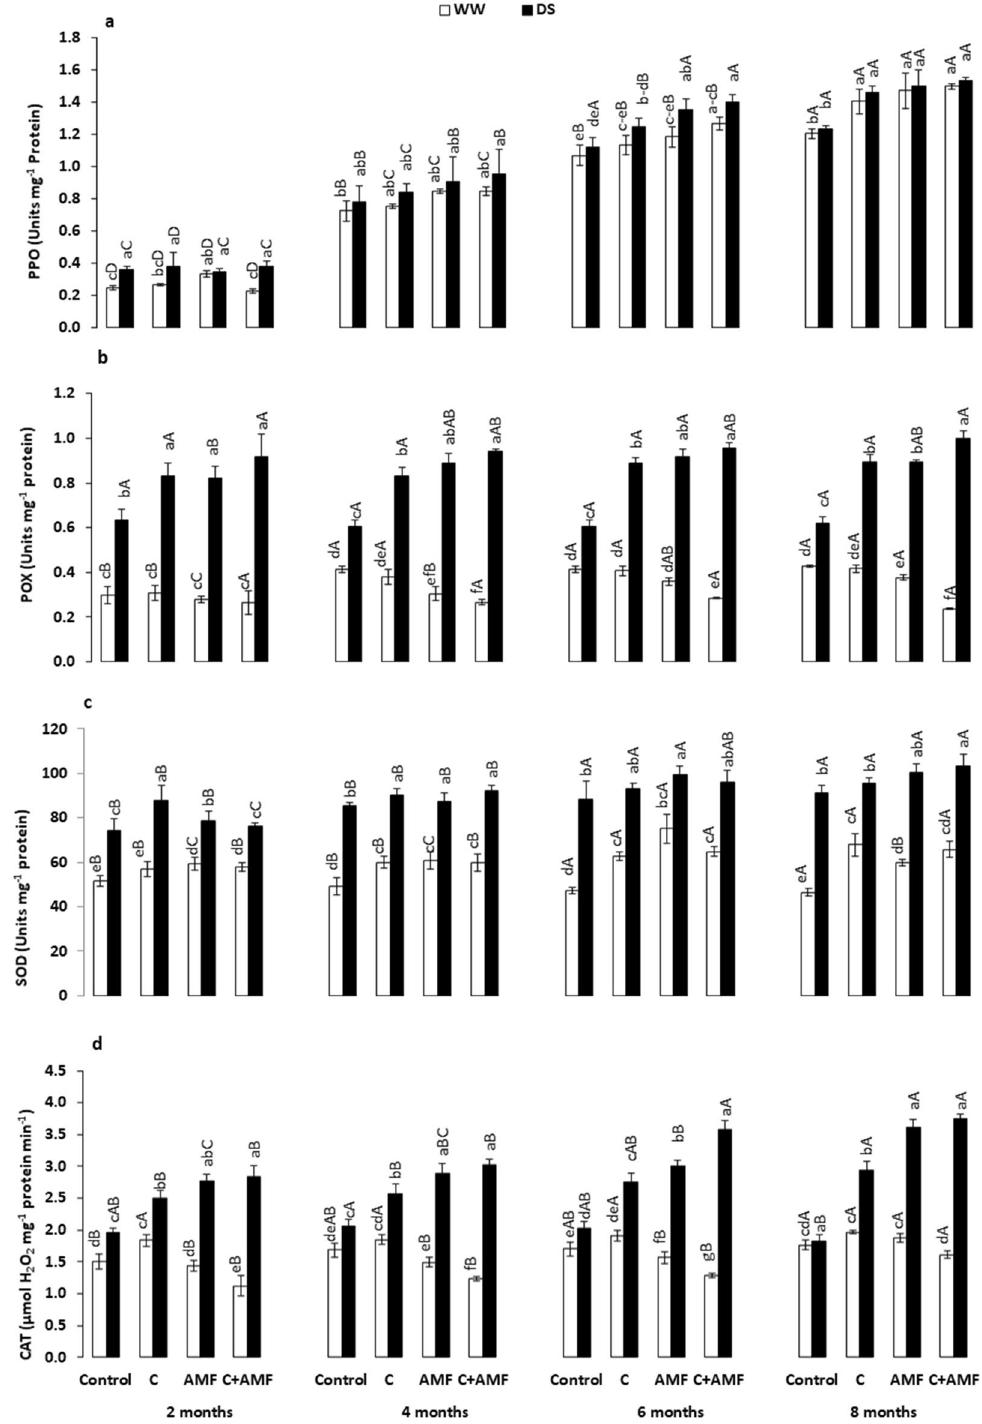
Figure 7. Effects of water regimes (WW: well-watered; open bars and DS: drought ( a ) polyphenoloxidase (PPO), ( b ) peroxidase (POX), ( c ) superoxide dismutase (SOD), and ( d ) catalase (CAT) activity in control carob plants and plants amended with compost (C) and/or assemblage of indigenous arbuscular mycorrhizal fungi (AMF). Data are mean ± SE (n = 5). Means followed by the same letters within the same time point are not significantly different at P < 0.05 (Tukey’s HSD). The upper case represents the differences within WW or DS water regime, and the lower case represents the differences within a one-time